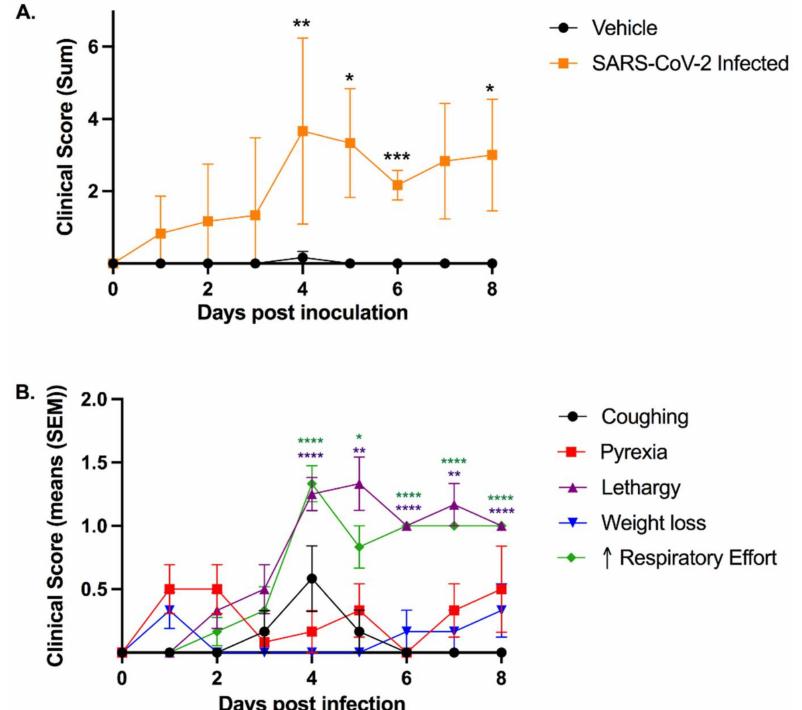
Figure 1. Intratracheal SARS-CoV-2 inoculation results in clinical disease. Clinical parameters were assessed using the feline respiratory disease clinical scoring system (see Table 1). ( A ) Clinical parameters summated to provide an overall clinical score per cat per day. Clinical disease severity peaked at 4 dpi and was significantly higher than sham-inoculated cats at 4 dpi ( p = 0.0054), 5 dpi ( p = 0.0257), 6 dpi ( p = 0.0004), and 8 dpi ( p = 0.0453). A noticeable trend in severity was also noted at 7 dpi as compared with sham-inoculated controls ( p = 0.0654). ( B ) Lethargy and increased respiratory effort were the most prominent clinical signs observed in SARS-CoV-2-infected cats, both of which were significantly increased between days 3 and 4 ( p = 0.0027; p = 0.0027) and remained significantly elevated in infected cats after 4 dpi as compared to day 0. Coughing was most prominent at 4 dpi and was identified in 4/12 infected cats. Pyrexia was noted in 8/12 cats over the course of the study. Data are expressed as means ± SEM. Statistical comparisons made via mixed-effects analysis. * p < 0.05; ** p < 0.01; *** p < 0.001; **** p <